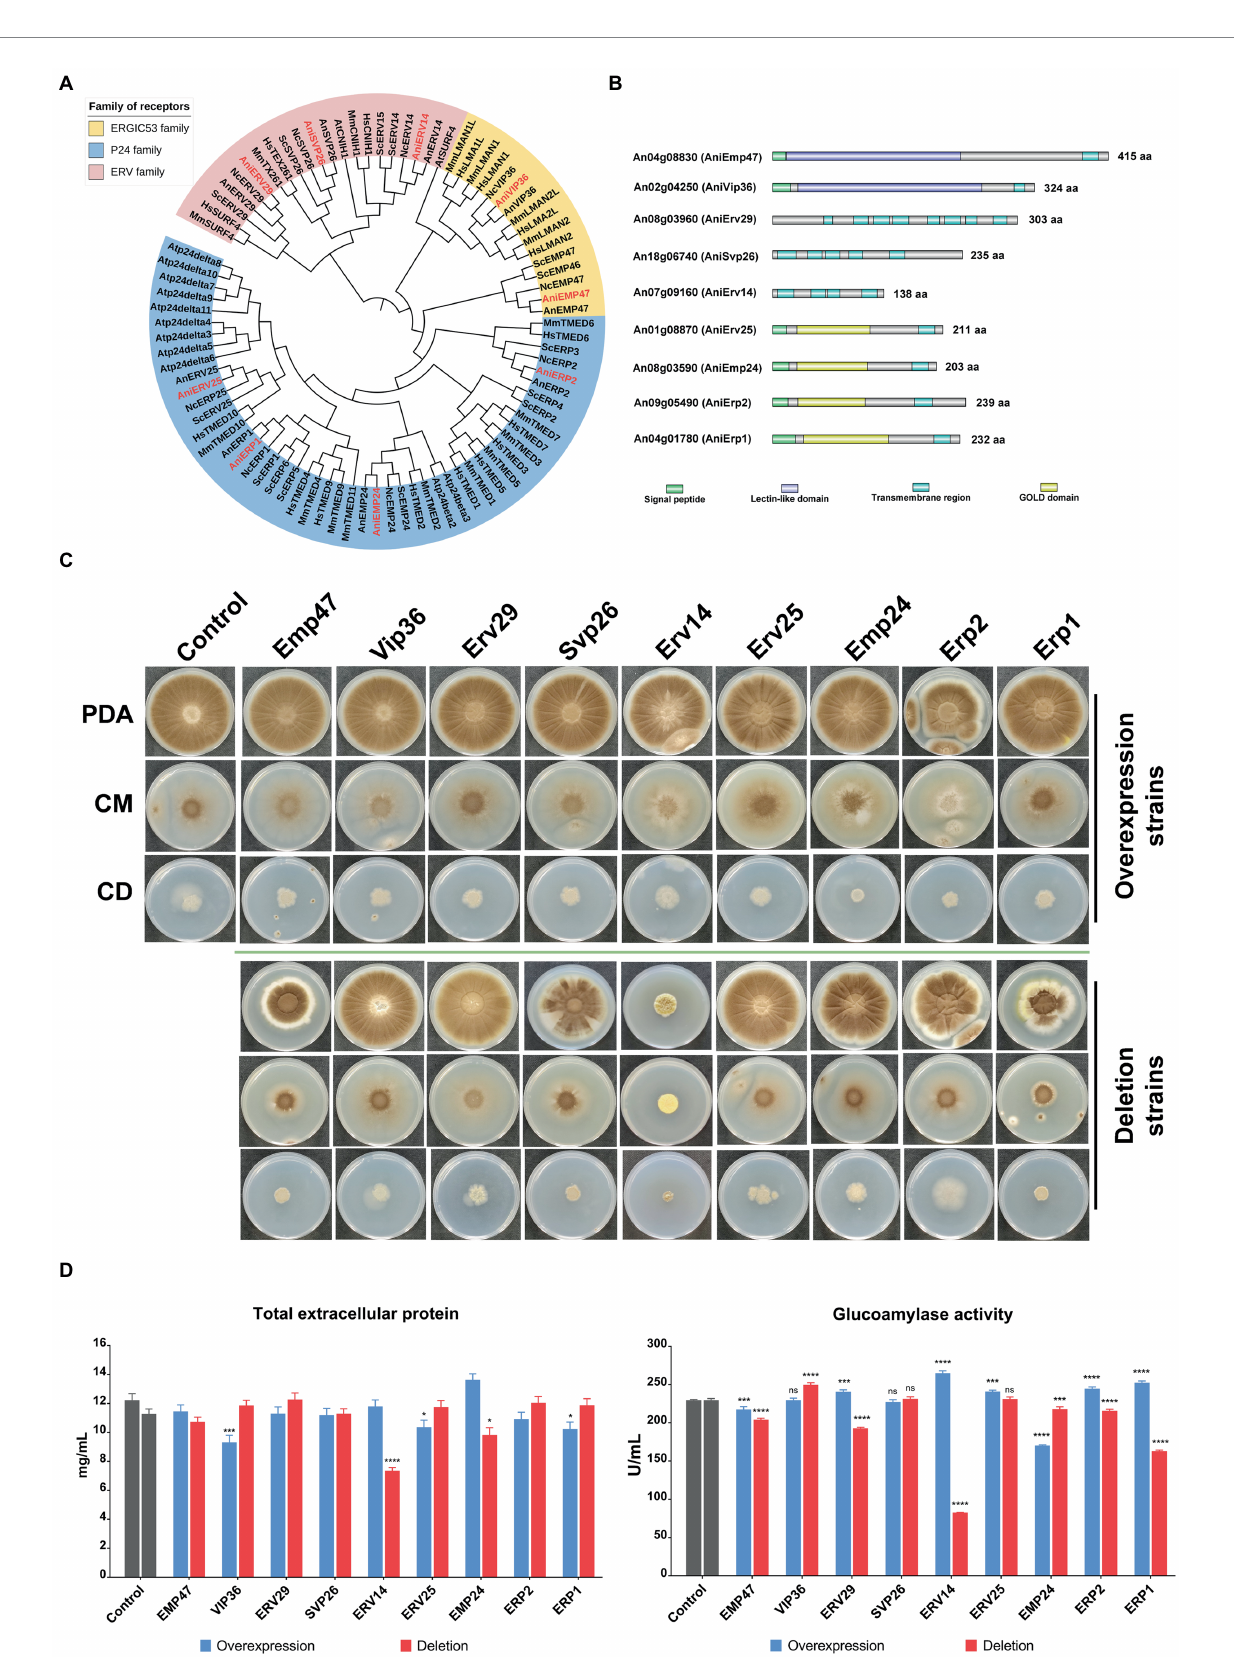
FIGURE 1 Characterization of putative cargo receptors of different families in Aspergillus niger. (A) Phylogenetic analysis of different receptor proteins in typical species and comparison of conserved regions of different receptors in A. niger . All protein sequences were obtained from the Uniprot database